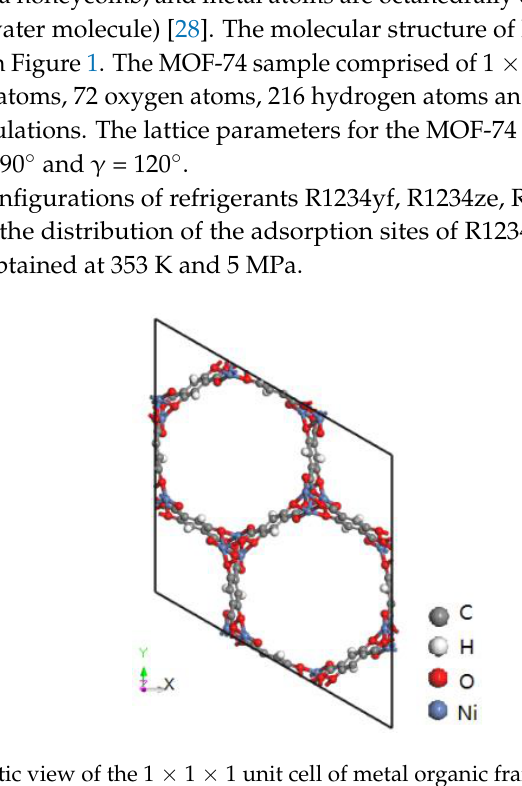
Figure 2. Atomic configurations of R1234yf ( a ); R1234ze ( b ); R134a ( c ) and R32 ( d ).